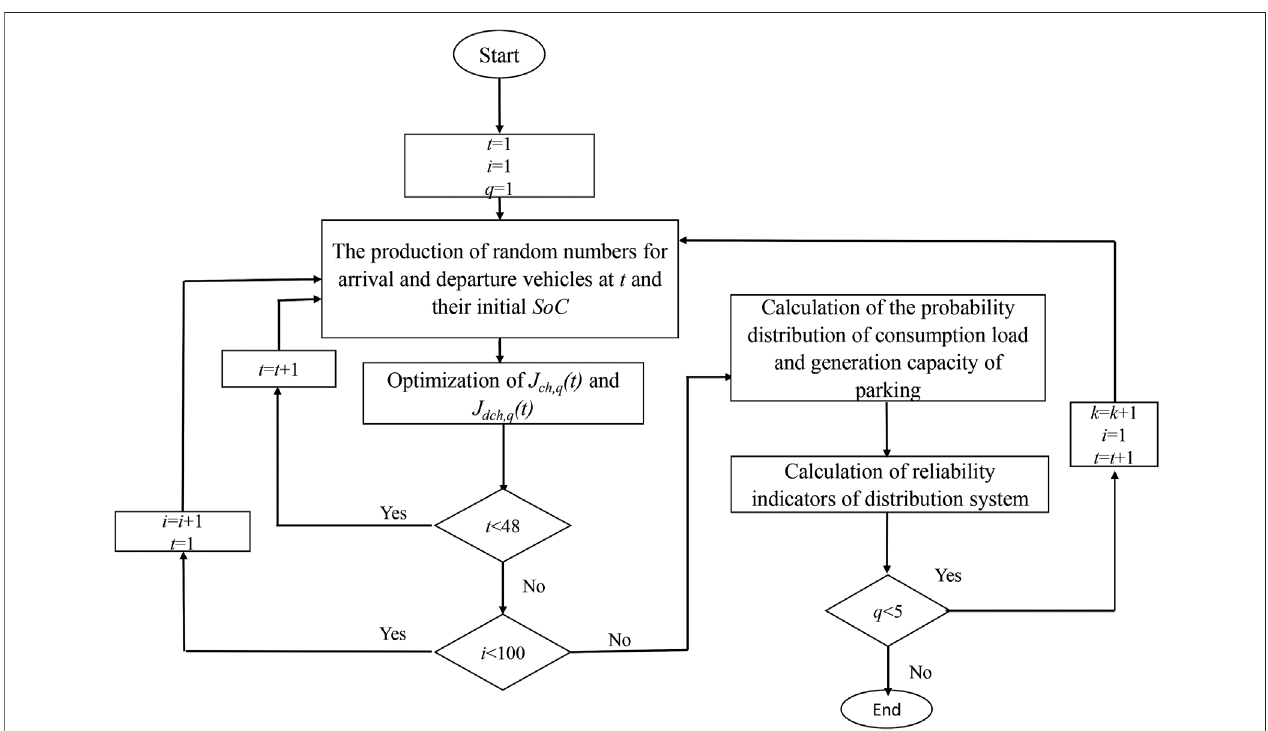
FIGURE 3 | Flowchart of calculating the reliability of the distribution system.